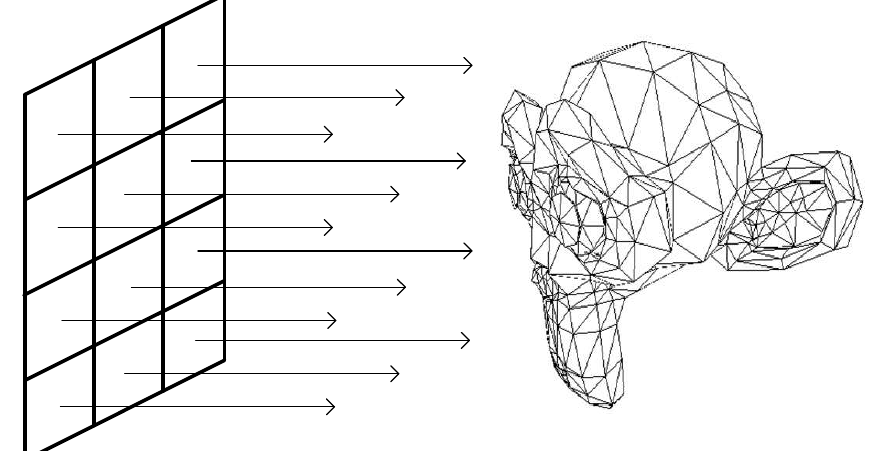
Figure 3. Schematic representation of our approaches to detect self-intersection (the image of triangular mesh is rendered by Blender).